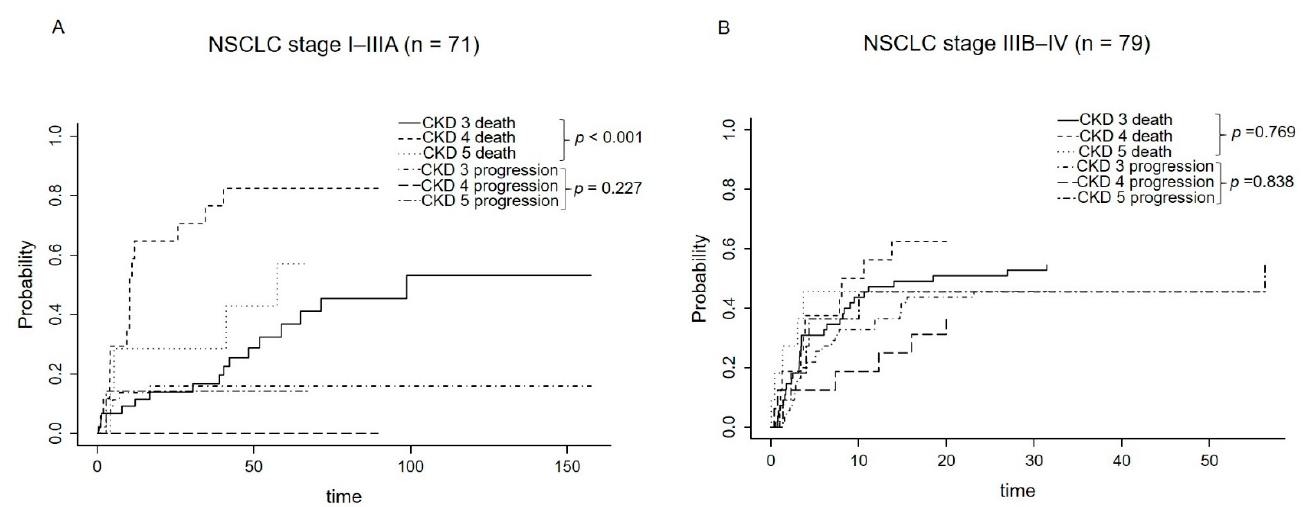
Figure 2. Cumulative incidence rate for progression and death from NSCLC in competing risks survival analysis stratified by the stage of CKD. ( A ) early NSCLC (stage ≤ IIIA), ( B ) advanced NSCLC (stage ≥ IIIB). Cumulative incidence rate for death from early NSCLC (stage ≤ IIIA) was lower in CKD stage 3.